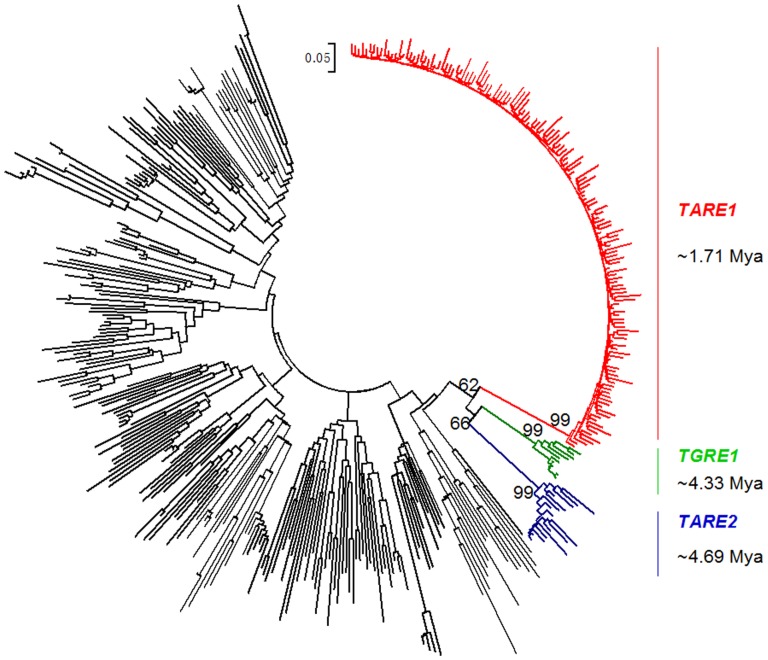
Phylogenetic tree based on the nucleotide sequences from a conserved copia-like RT domain.The RT sequences from tomato, rice, soybean and Arabidopsis were aligned using the MUSCLE program, and then the tree was reconstructed using the MEGA 5 program (see Materials and Methods). For a better visualization, only the elements from tomato TARE1, TGRE1, and TARE2 families, and exemplars from other species are shown.